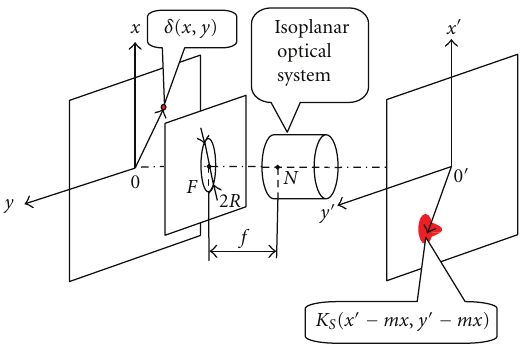
Figure 6: An isoplanar optical system with telecentric stop in object